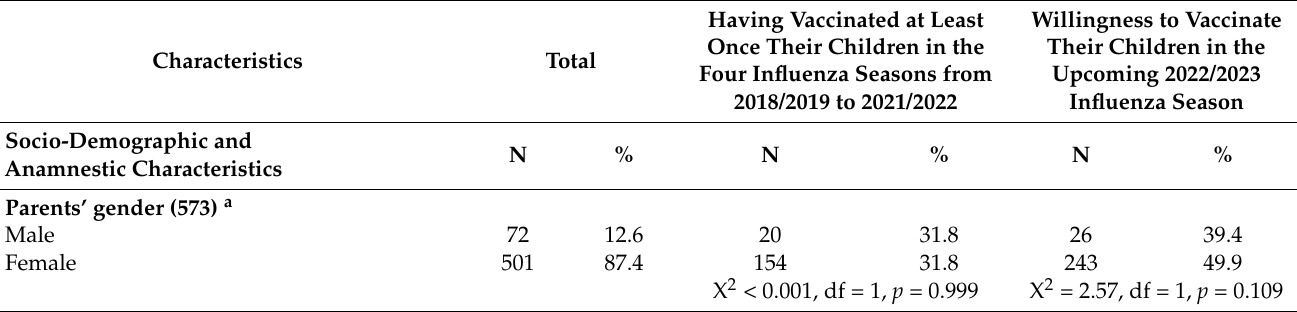
Table 1. Main characteristics of parents participating in the survey, the associated influenza vaccina- tion uptake, and willingness to vaccinate their